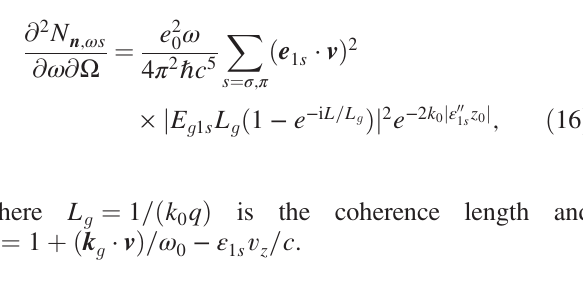
FIG. 1. Schematic setup for the generation of PMR in the EAD geometry. The electron beam moves uniformly with velocity v in the x direction. The crystal surface lies in the x - y plane. g is the reciprocal crystal lattice vector. PMR will be mainly emitted in the direction given by the vector k 0 ¼ − k ¼ − k 0 ð sin θ 0 cos ϕ 0 ; sin θ 0 sin ϕ 0 ; cos θ 0 Þ , and thus rapidly leaves the crystal without significant k þ g and θ electronic absorption. k is the Bragg angle. The energy of the PXR is tuned using the angle ψ 0 between the electron g ¼ B velocity and the projection g ⊥ of g on the crystal